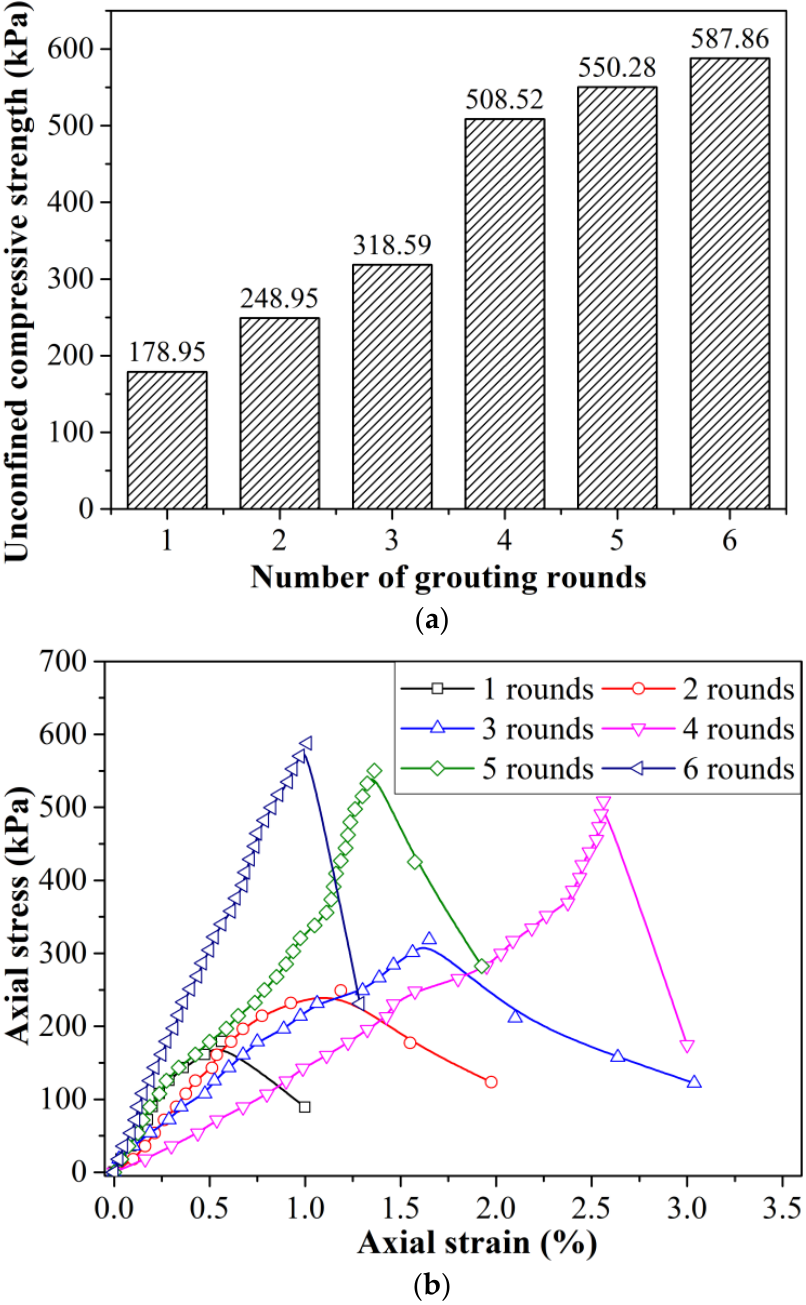
Figure 2. Strength characteristic curve of biocemented tailings with different grouting rounds: ( a ) UCS diagram of biocemented tailings with different grouting rounds; ( b ) stress–strain curve of biocemented tailings with different grouting rounds.